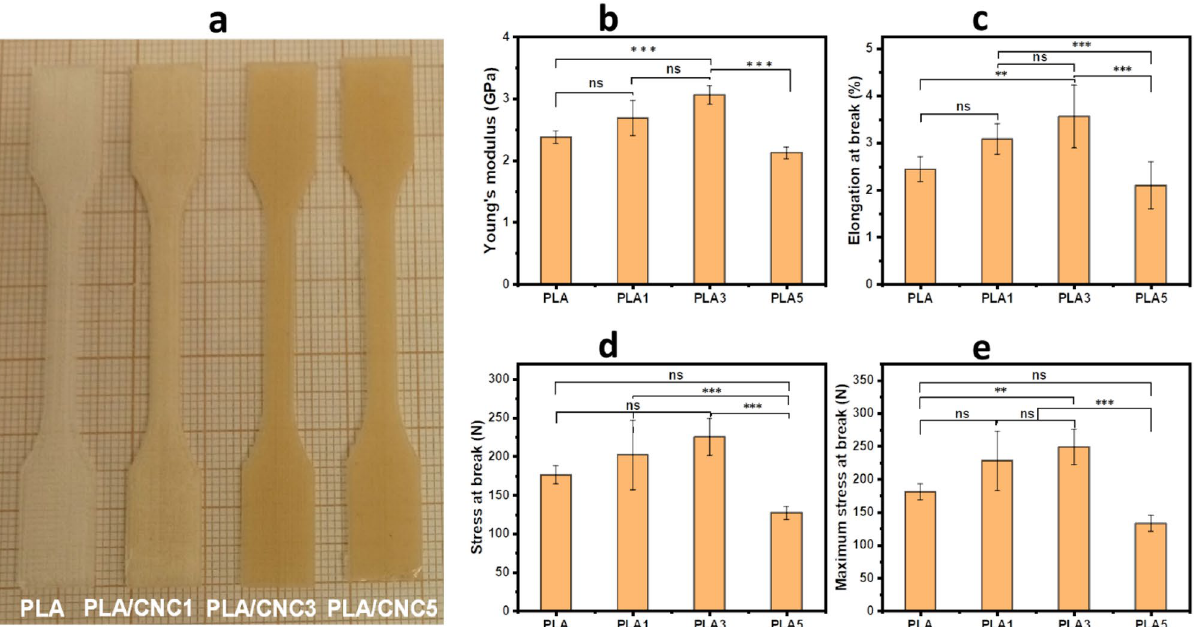
Figure 3. Mechanical properties: ( a ) Photo of dog bone shaped PLA and PLA/CNCx scaffolds for tensile strength testing. ( b ) Young’s modulus. ( c ) Elasticity limit tensile. (d&e) stress at break (*** p ˂ 0.001, ** p < 0.01, ns = not